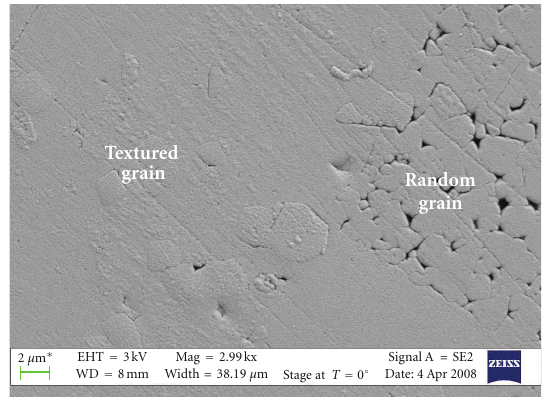
Figure 24: High-magnification SEM micrograph of PZT-PZN showing textured grain and randomly oriented grain